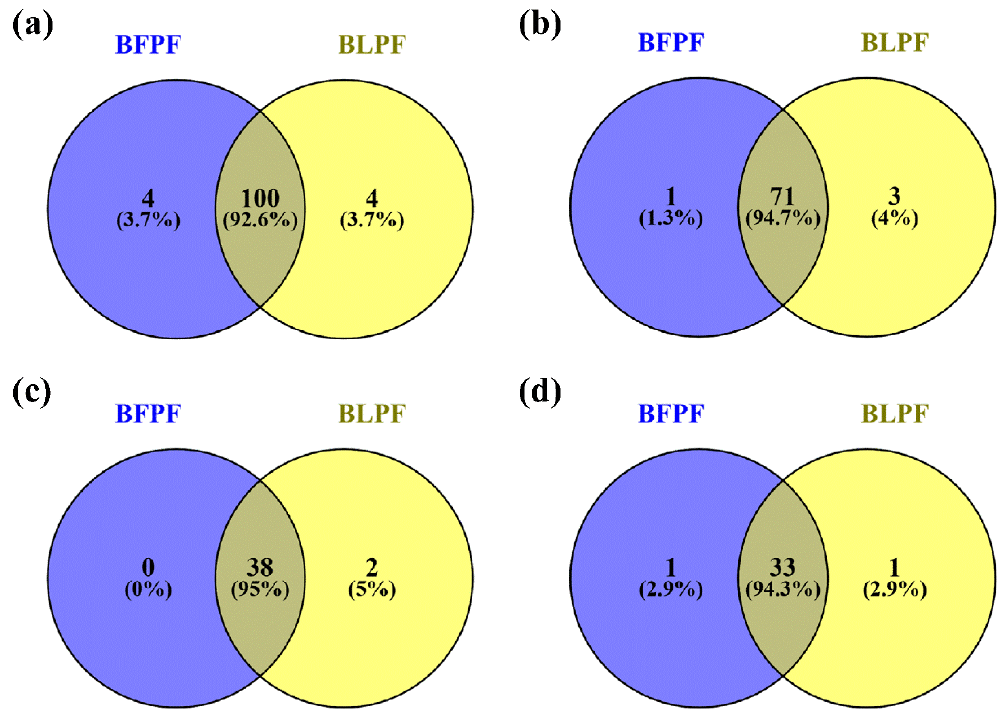
Figure 5. Venn diagrams showing the qualitative comparison between the two extracts: ( a ) of all the identified compounds, 100 (92.6%) are in common between the two extracts; ( b ) 94.7% of the identified polyphenols are in common; ( c ) all the flavones identified in BFPF are also present in BLPF which contains 2 more flavones; ( d ) of the identified flavanones, 33 (94.3%) are present in both the extract.